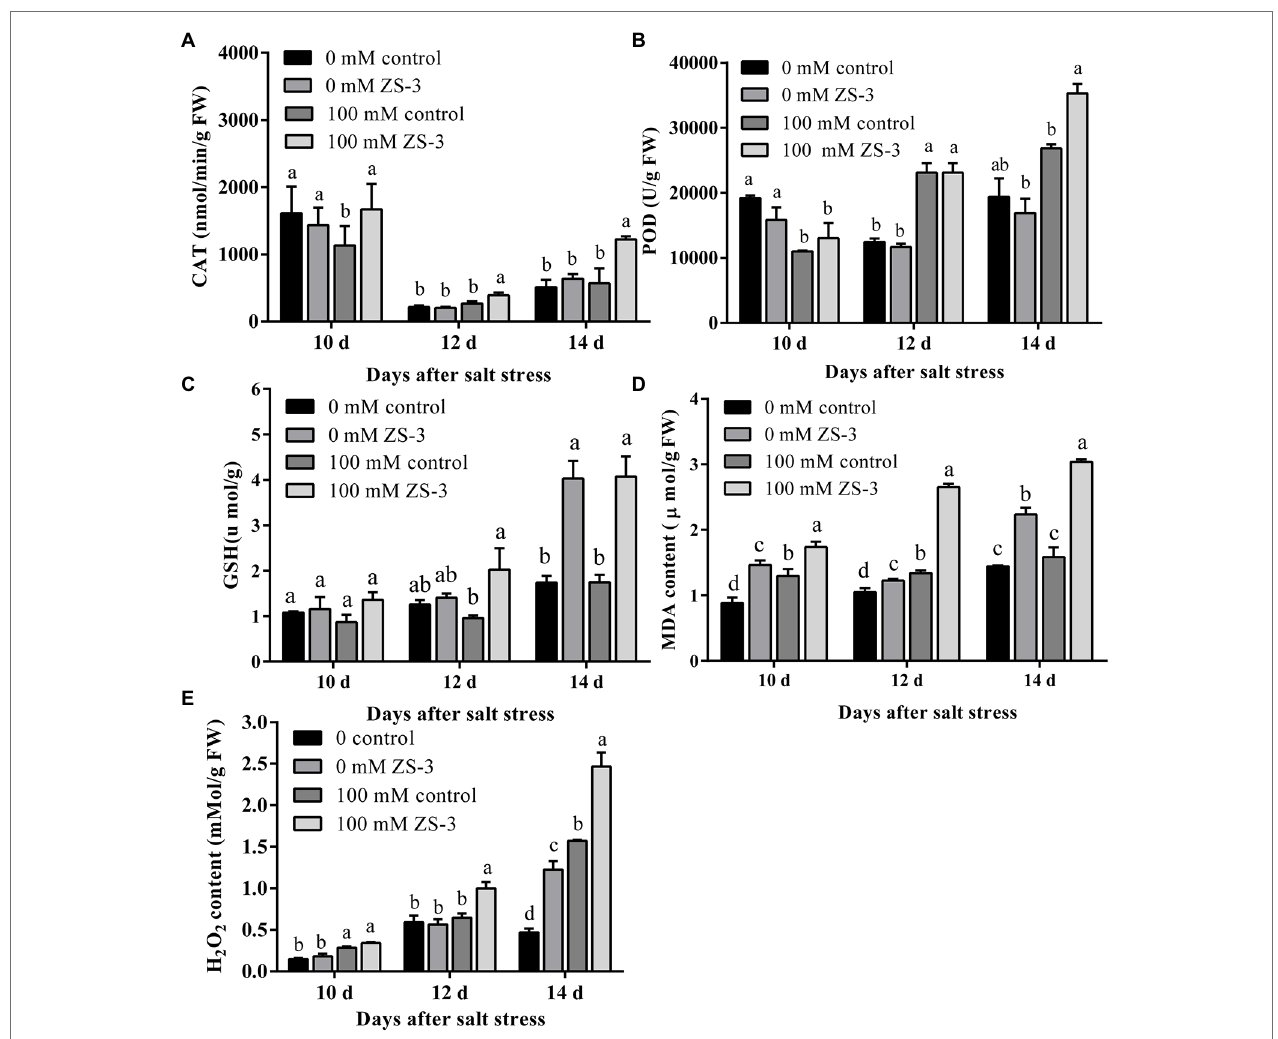
FIGURE 5 | Effect of ZS-3 inoculation on antioxidant substances and ROS in Arabidopsis thaliana . CAT (A) , POD (B) , GSH (C) , MDA (D) , and H 2 O 2 (E) were measured in Arabidopsis thaliana at 10, 12, and 14 days after inoculation with strain ZS-3 in the absence or presence of 100 mM NaCl. The results are the mean ± standard deviation of three independent experiments. Different lowercase letters on the bars represent significant differences between treatments based on one-way ANOVA (Duncan’s multiple range, p <